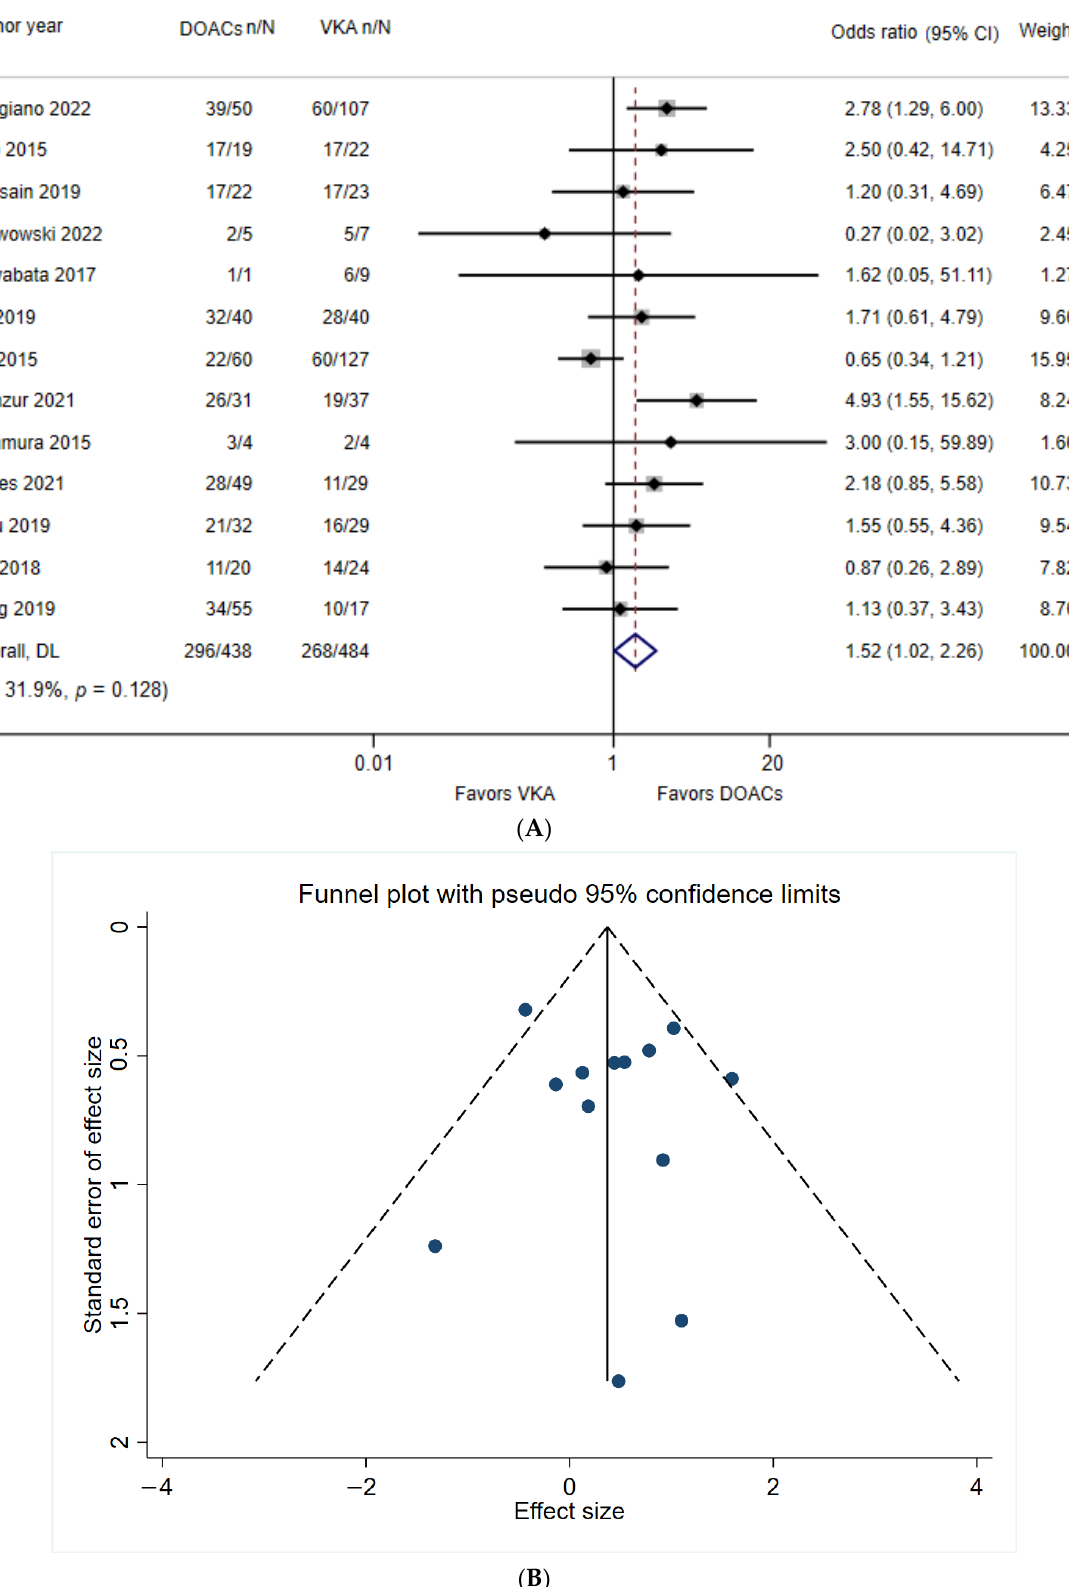
Figure 3. ( A ) The forest plot of random-effect meta-analysis of the likelihood of resolution of left arterial appendage thrombus under the use of VKA and DOACs. ( B ) The funnel plot of the studies included in the meta-analysis of the likelihood of resolution of left arterial appendage thrombus under the use of VKA and DOACs.